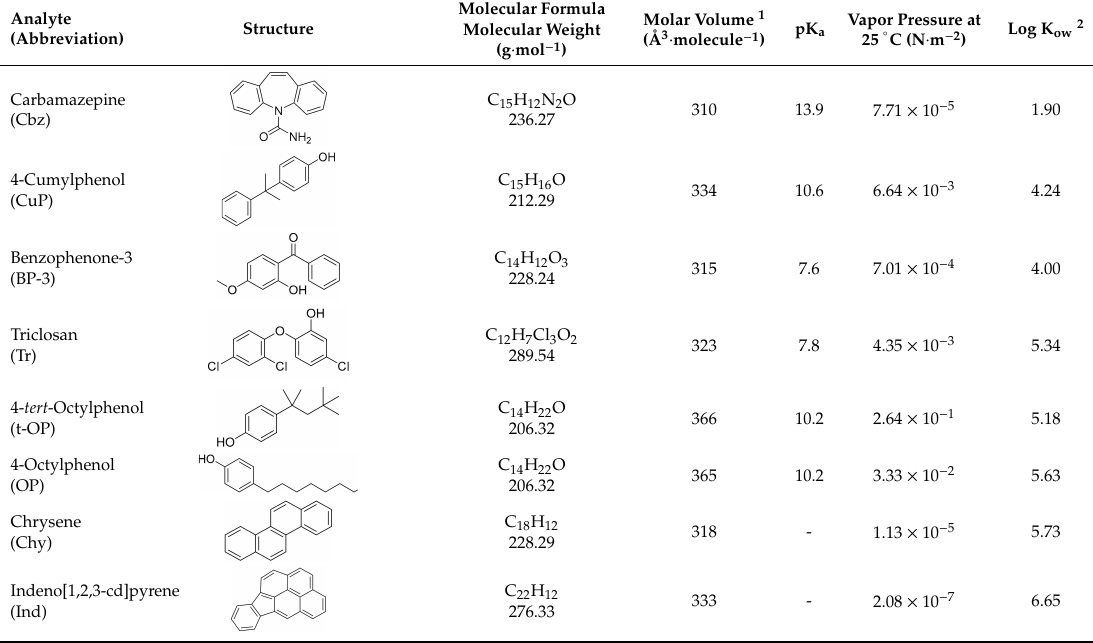
Table 1. Several physicochemical properties of the analytes studied (SciFinder ®